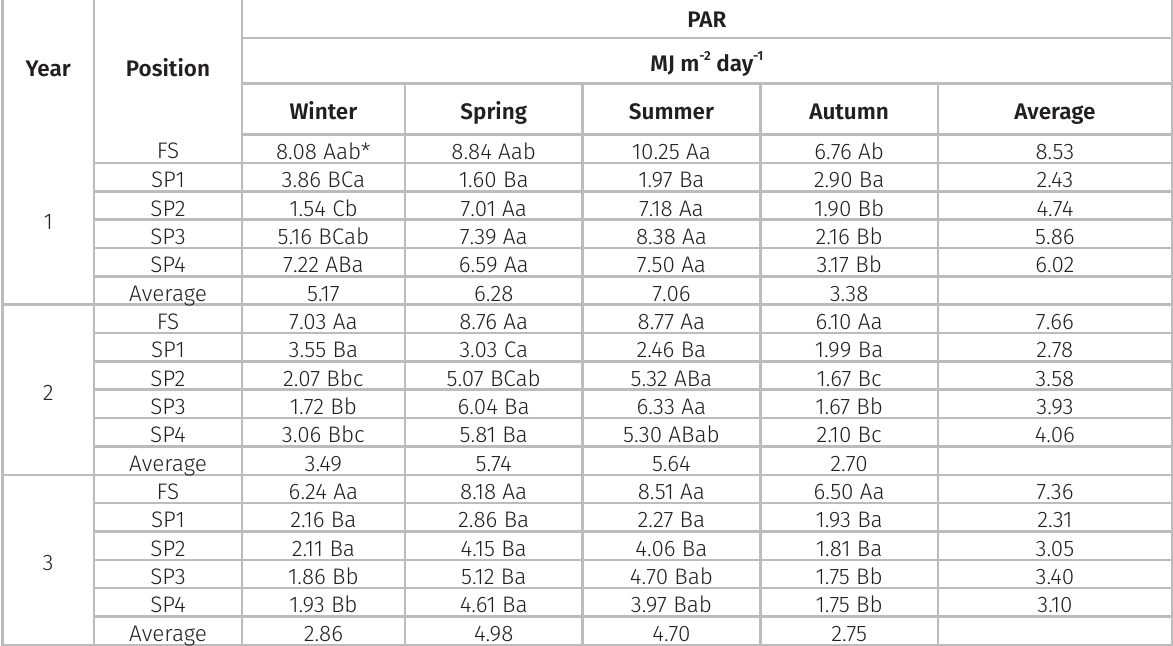
Table II. Photosynthetically active radiation (PAR) incidence at the full sun (FS) and at the four positions within the silvopastoral system (SP1: 0.00 m, SP2: 3.75 m, SP3: 7.50 m and SP4: 11.25 m from the North row), in each season of the three study